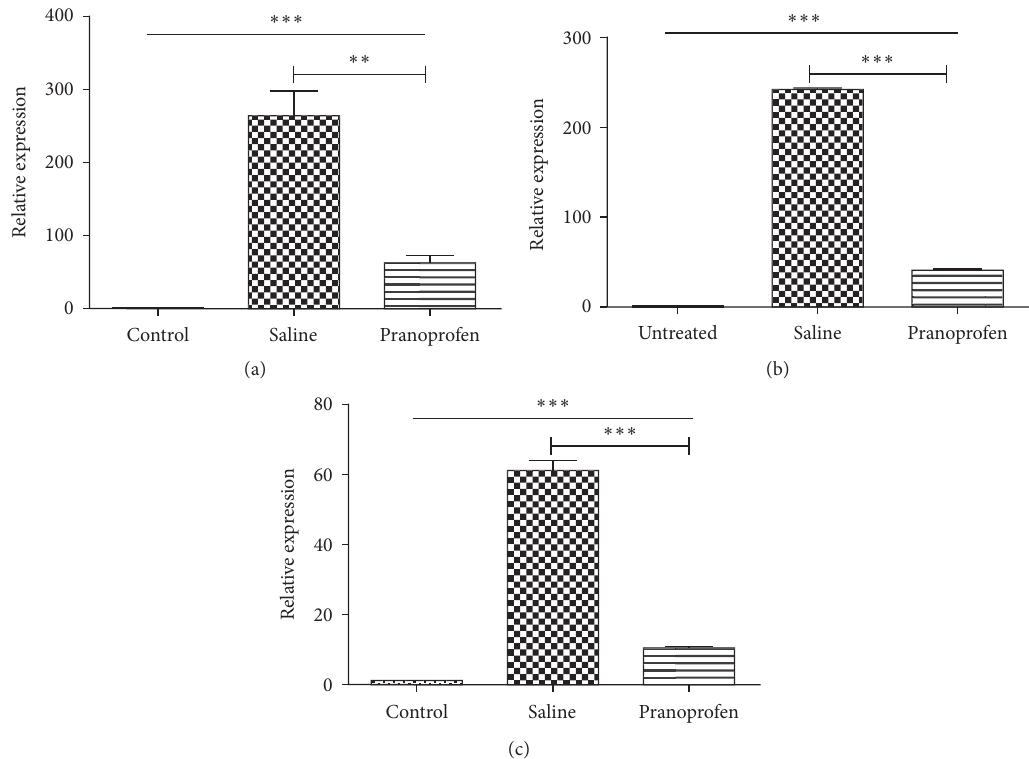
Figure 3: The mRNA expression of NLRP3, IL-1 β , and MMP-13 in all groups of cornea. The control group was used as the reference. (a) The mRNA expression of NLRP3 in the pranoprofen group (60.80 ± 10.61) was lower than that of the saline group (264.40 ± 33.45). (b) The mRNA expression of IL-1 β in the pranoprofen group (40.41 ± 0.50) was lower than that of the saline group (241.30 ± 2.56). (c) The mRNA expression of MMP-13 in the pranoprofen group (10.07 ± 0.22) was lower than that of the saline group (60.81 ± 2.73). Data are shown as mean ± SD; n � 6, ∗∗ P < 0 . 01, ∗∗∗ P < 0 .